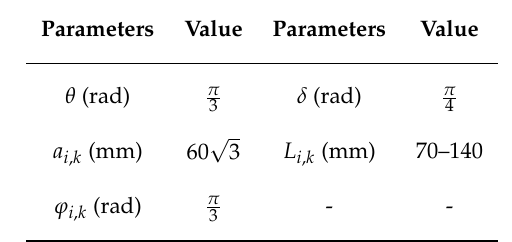
Table 2. Robot parameters used in the simulation validation ( i denotes the sequence number of